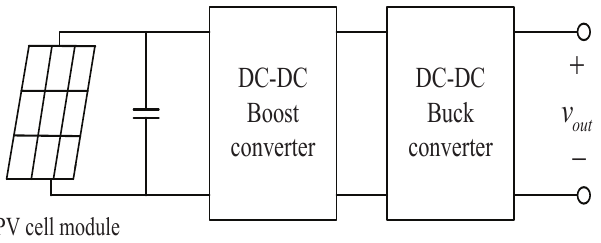
Figure 1. Two-stage grid-tied PV system